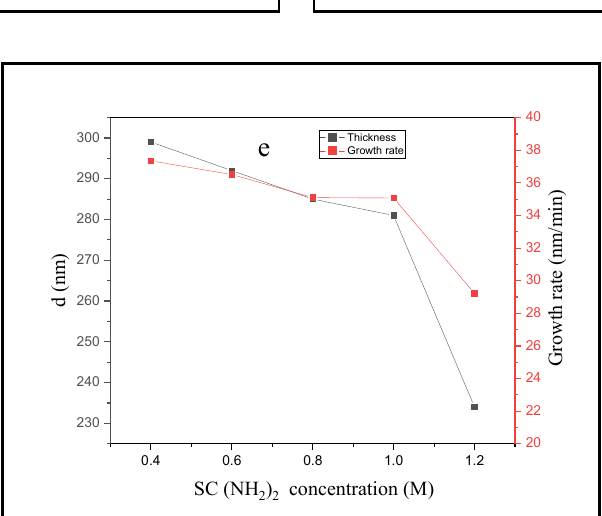
Figure 2. The thickness and growth rate variation of Cu 2 S thin films as a function of deposition parameters: ( a ) Deposition time, ( b ) bath temperature, ( c ) CuSO 4 .5H 2 O concentration, ( d ) pH value, ( e ) and SC (NH 2 ) 2 concentration.